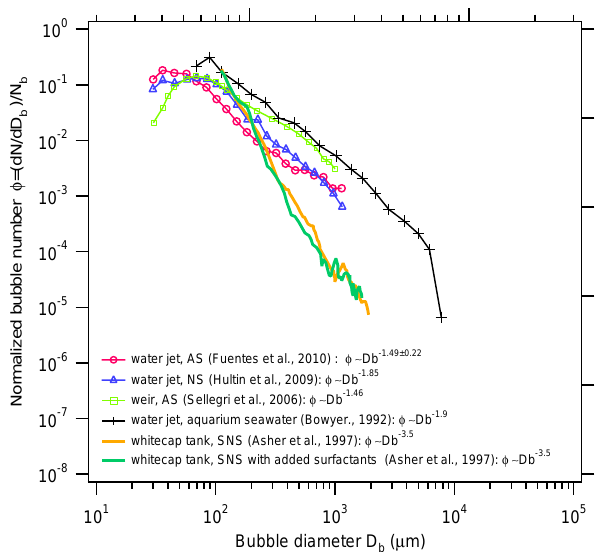
Fig. 7. Comparison of normalized bubble populations generated by seawater impingement in different laboratory studies. The wa- ter impingement-generated bubble distributions present a common dominant mode in the 40µm to 110µm bubble size region fol- lowed by a decrease in the bubble number with power-law expo- nents between 1.46–3.5 (AS=artificial seawater, NS=natural seawa- ter, SNS=sterilised natural